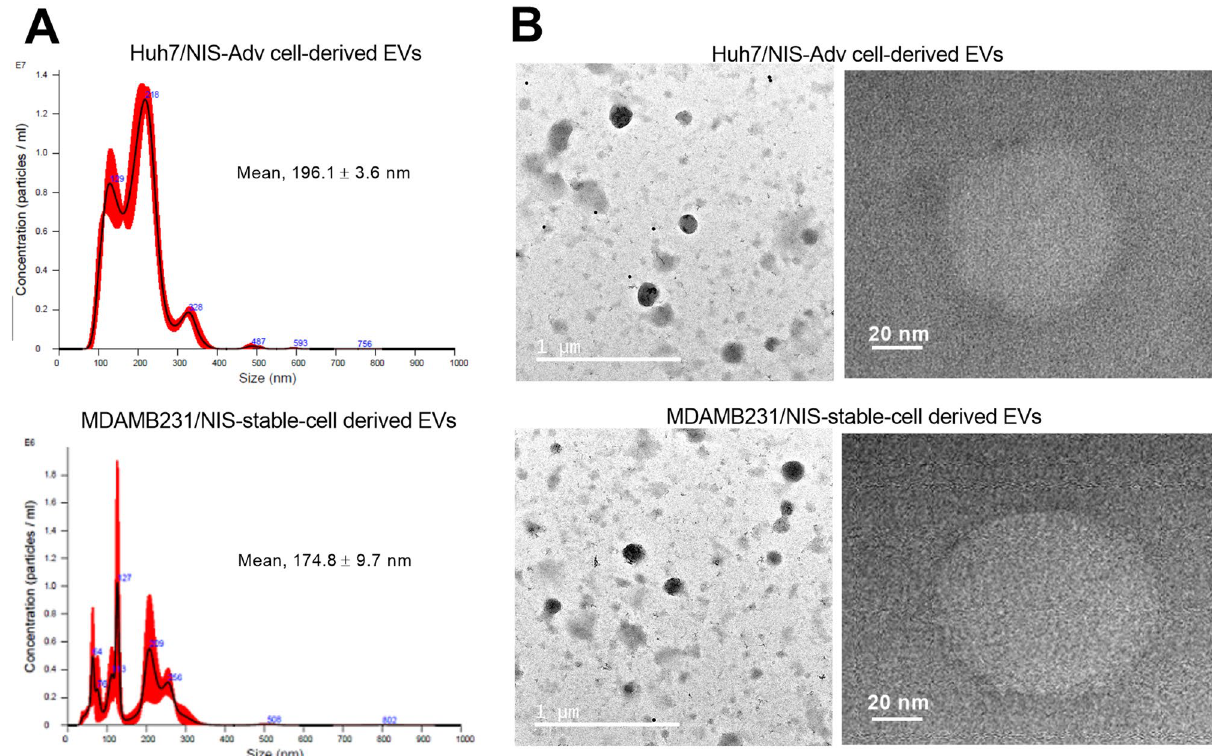
Figure 2. TEM and size distribution of EVs from NIS-expressing cancer cells. ( A ) Nanosight analysis profiles of EVs derived from Huh/NIS-Adv cells (top) and MDAMB231/NIS-stable donor cells (bottom). ( B ) Representative TEM images of EVs derived as above. Magnifications are × 10,000 and × 200,000, and scale bars are 1 μm and 20 nm, (Fig. 4c). EVs from MDAMB231/NIS-stable donor cells increased 125 I uptake of recipient Huh7, HepG2, and T47D cancer cells to 545.4 ± 47.2%, 1641.2 ± 114.7%, and 597.5 ± 11.0% of the control level, respectively (Fig. 4c). NIS‑loaded EVs enhance the efficacy of 131 I radiotherapy on recipient cancer cells.